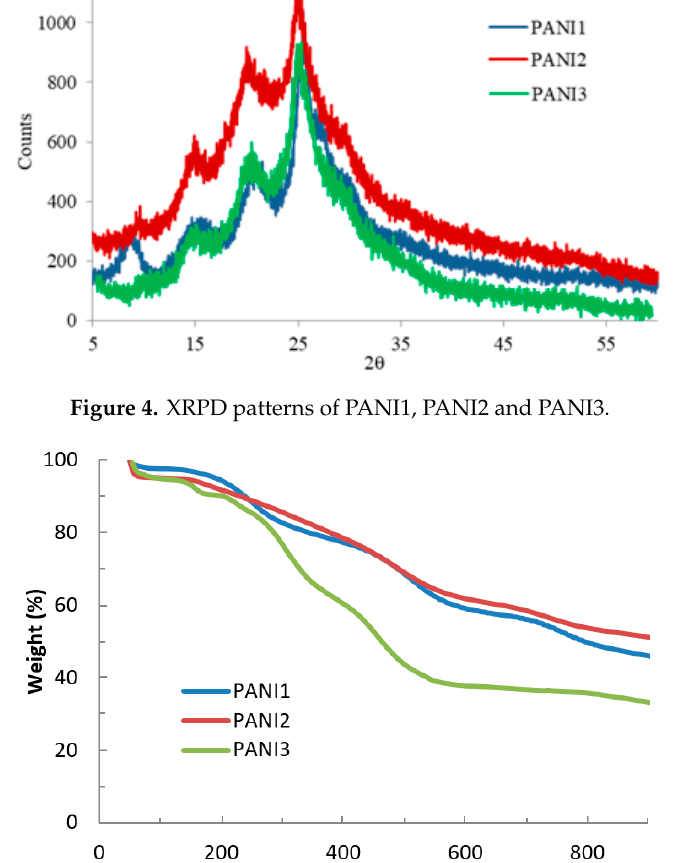
Figure 5. TGA curves of PANI1, PANI2 and PANI3. In agreement with the literature [16], TG analyses of all the materials performed in air show four main weight loss stages: the first one at around 100 °C is caused by the loss of physisorbed water, the loss of the dopant (HCl) is responsible for the second one (150–300 °C), the third one (350–600 °C) is caused by oligomeric chains degradation and finally the fourth one, starting at around 600 °C, is attributed to the polymer backbone degradation. The results show that, if compared to PANI1 and